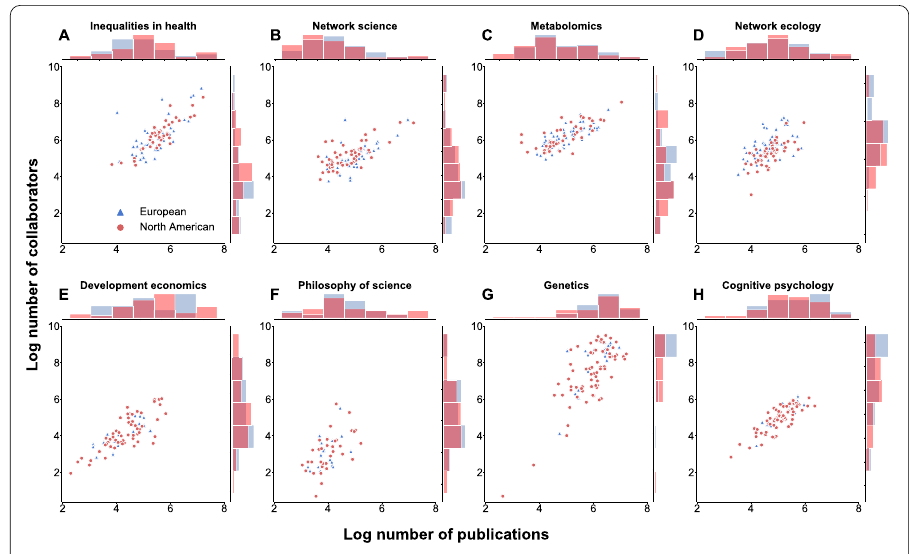
Figure 1 Total number of collaborators and publications for prominent researchers. ( A )-( H ) Logarithm of the total number of collaborators as a function of the logarithm of the total number of publications for each prominent researcher in: ( A ) inequalities in health, ( B ) network science, ( C ) metabolomics, , ( D ) network ecology, ( E ) development economics, ( F ) philosphy of science, ( G ) genetics and ( H ) cognitive psycology. Red circles and blue triangles correspond to prominent researchers based in North America and Europe, respectively. We test whether the points are distributed differently using the 2D Kolmogorov-Smirnov statistic [28], and calculate the significance by resampling the researchers’ affiliations. At the 5% confidence level, we can only reject the null hypothesis (that both subsets are drawn from the same distribution) in the case of network